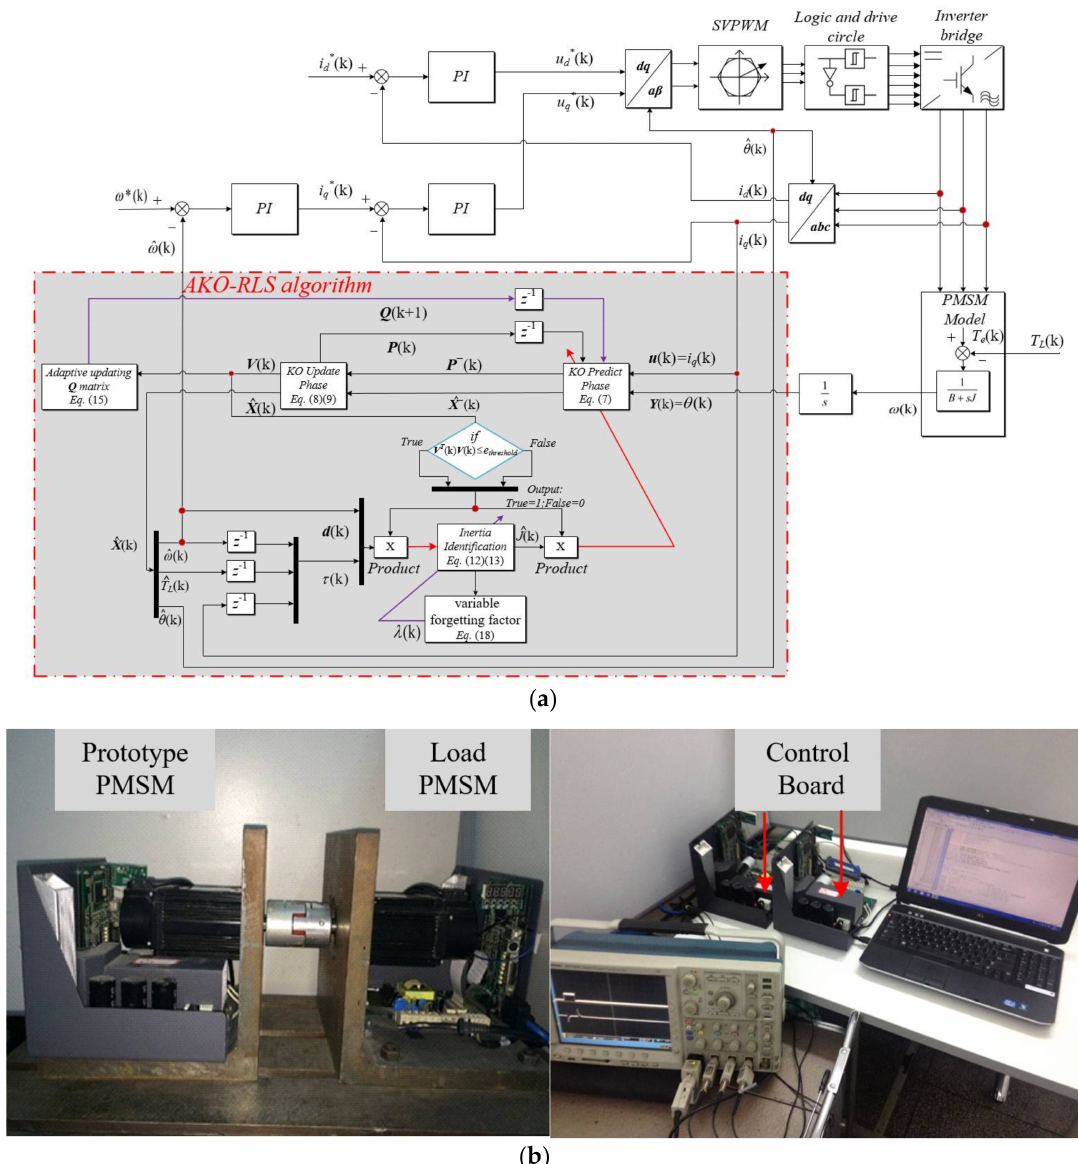
Figure 1. Overall Schematic diagrams and photographs of hardware platform for system parameter estimation. ( a ) Structure diagram of the integral PMSM drive system with AKO-RLS algorithm; ( b ) photographs of experiment